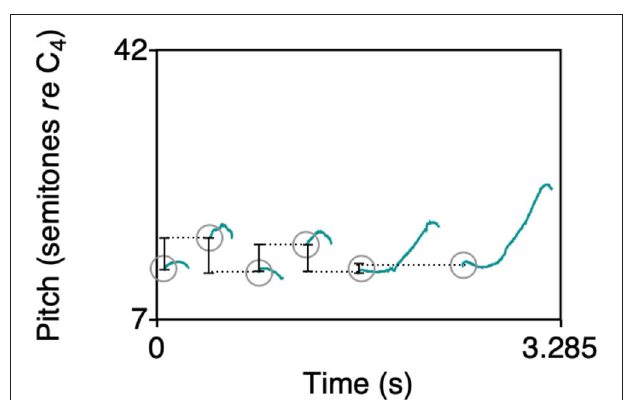
FIGURE 4 | A whistle, plotted as pitch track on a semitone scale (green lines), where onsets are indicated in grey circles, and black lines show onset-to-onset intervals. For computing the interval compression ratio, the individual segments in each whistle are shuffled 100 times and the mean absolute differences between shuffled onsets are